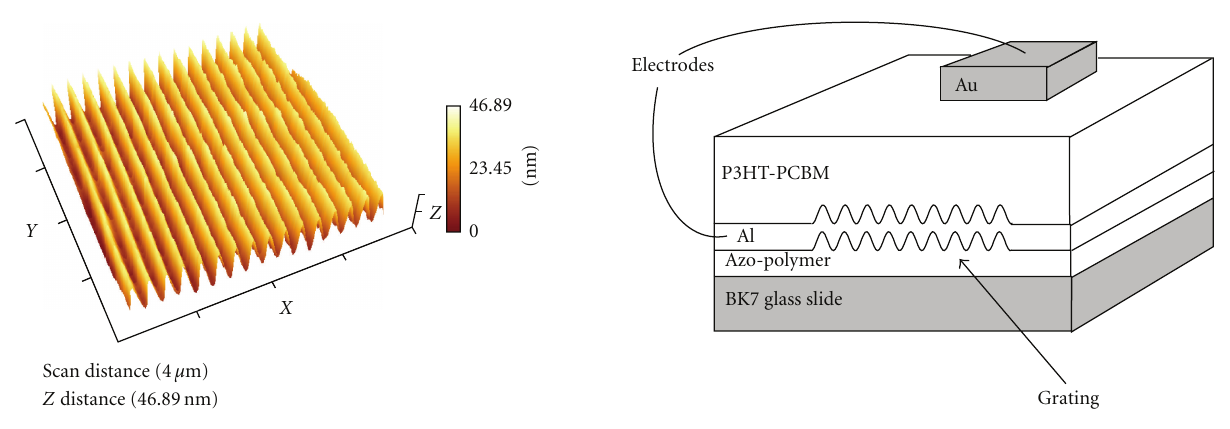
Figure 2: A cut-away side view of the test